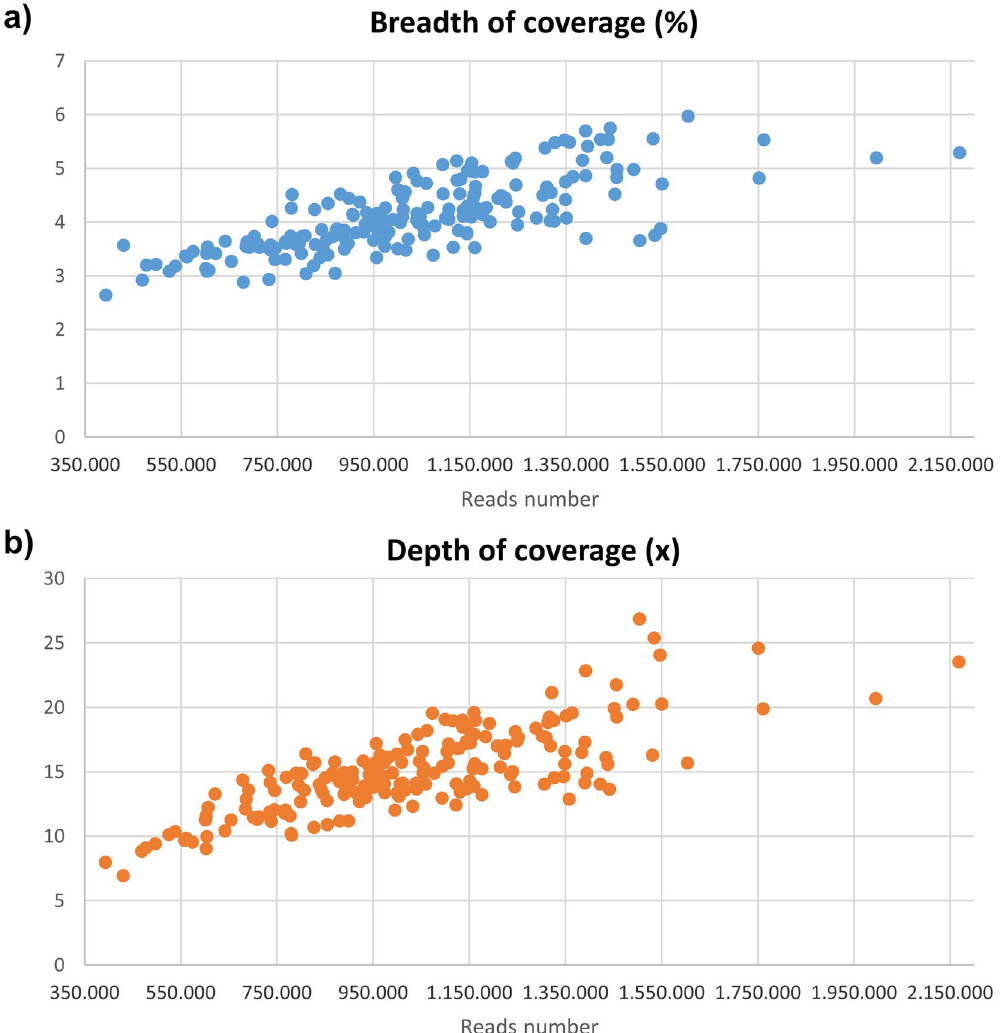
Figure 2. Increase of genome coverage by sequencing yield. The breadth ( a ) and depth ( b ) of coverages are